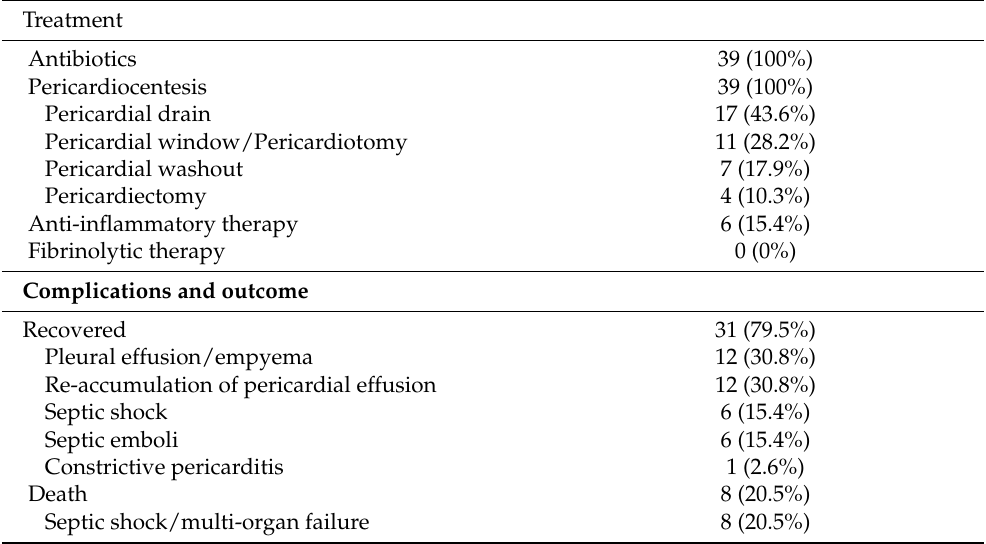
Table 3. Treatment and outcome in MRSA pericarditis